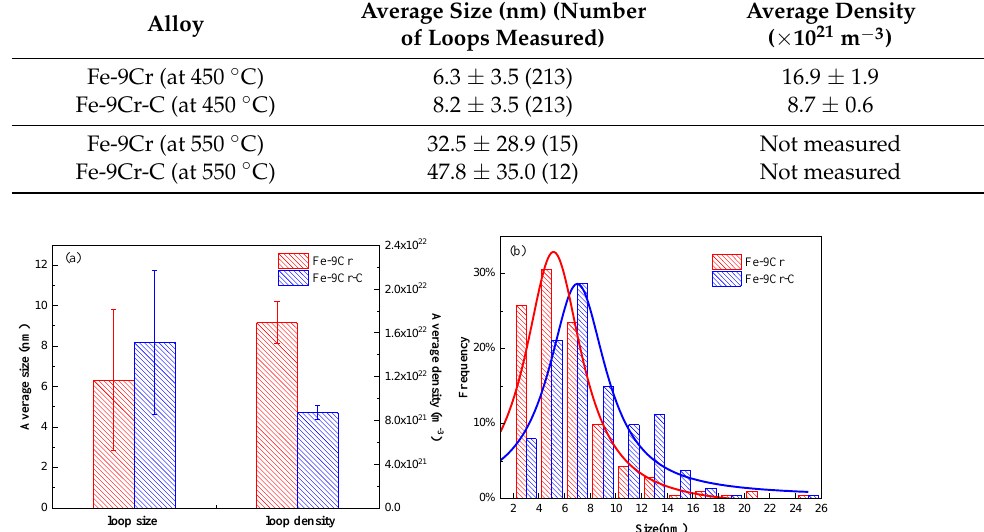
Figure 3. TEM bright-field micrographs showing the high-density loops in Fe-Cr alloys irradiated at 450°C: ( a ) Fe-9Cr imaged along the (111) zone axis; ( b ) Fe-9Cr-C imaged along the (133) zone axis. Table 3. Summary of the average size and density of the dislocation loops in the Fe-Cr alloys. Average Size (nm) (Number Alloy of Loops Measured)